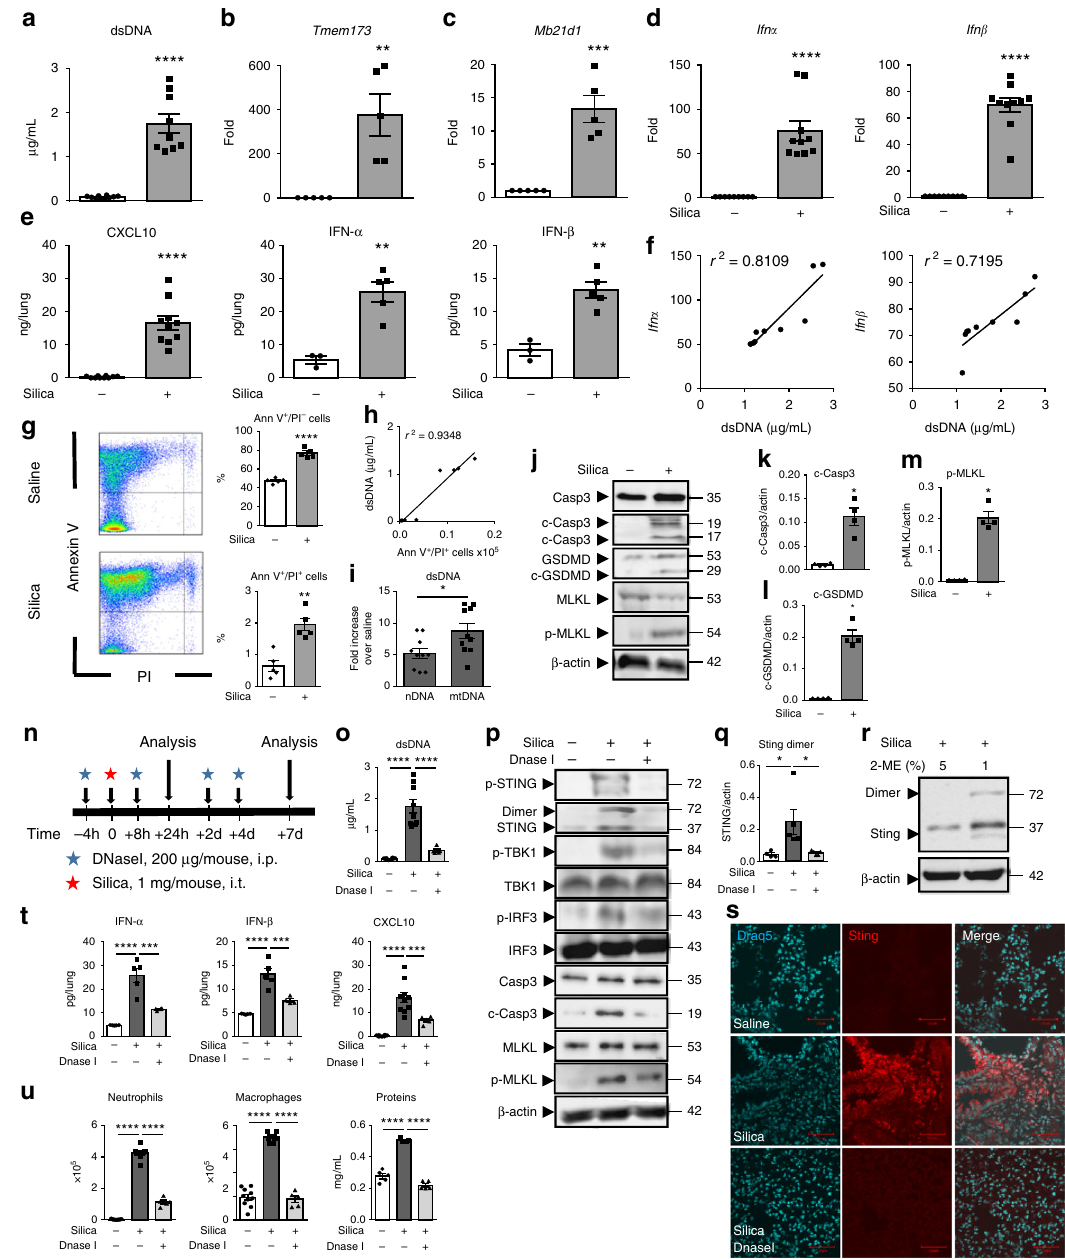
Fig. 1 Self-dsDNA release is central to silica-induced lung in fl ammation and type I IFN response. a – m Silica microparticles (1 mg/mouse, i.t.) or saline were administered in WT mice and parameters were analyzed on day 7. a Concentration of extracellular dsDNA in the acellular fractions of bronchoalveolar lavage fl uid (BALF). b – d Tmem173 , Mb21d1, Ifn α , and Ifn β transcripts in the lungs and normalized to Gapdh expression. e Lung CXCL10 determined by ELISA